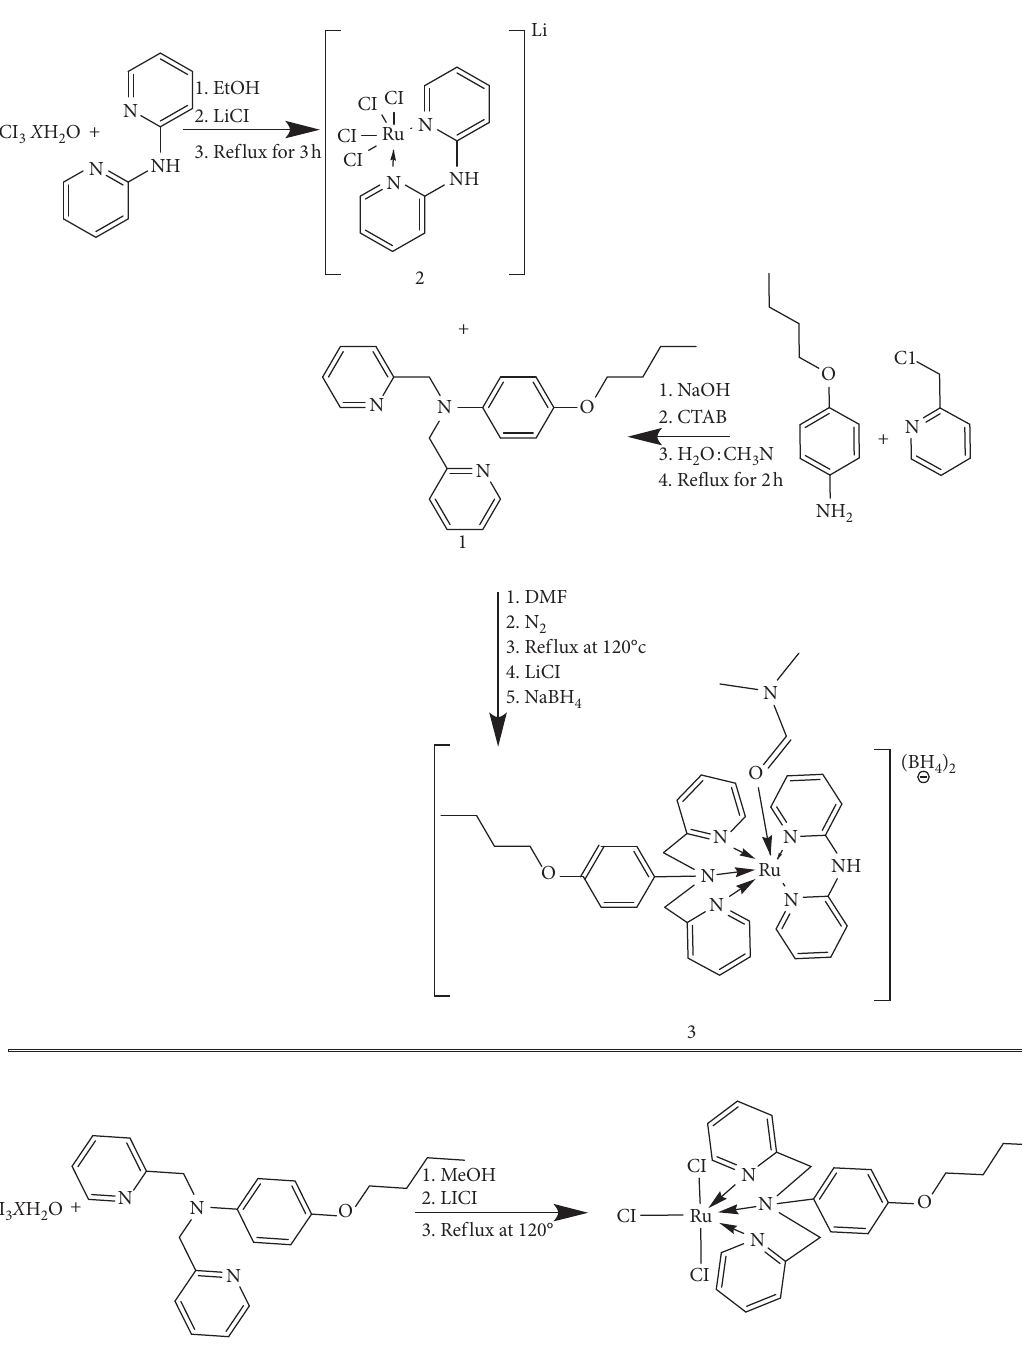
Figure 1: Synthetic routes for the ligand BUT (2) and ruthenium complexes: Li[Ru(Cl) and [Ru(BUT)(Cl) 3 ] (4)